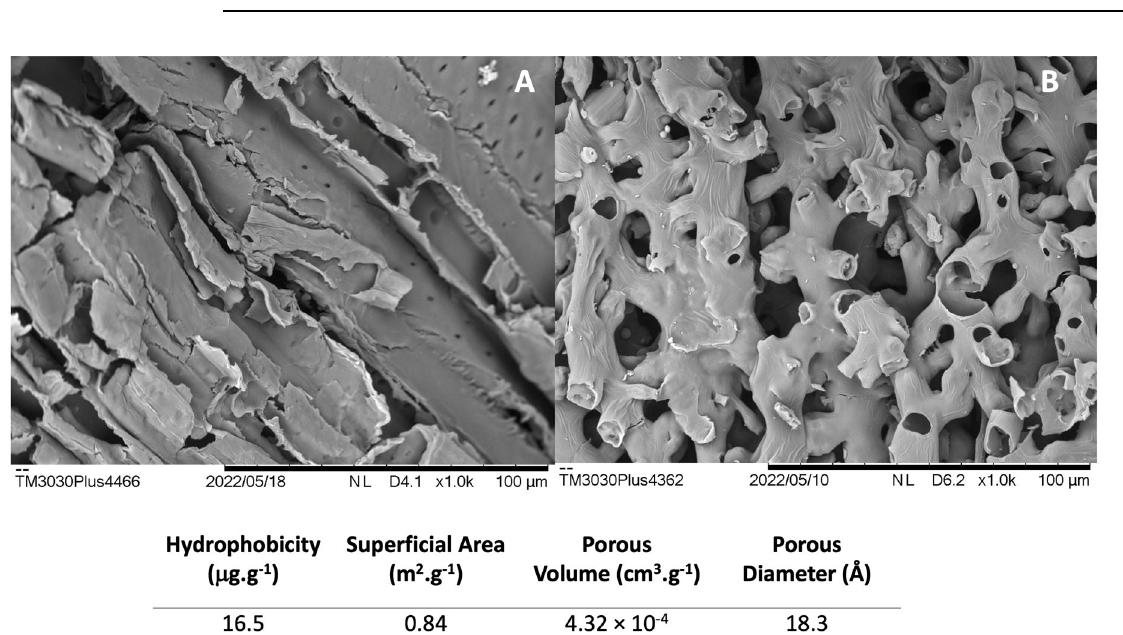
Figure 5. SEM of CC support applied on immobilization of L Asp and hydrophobicity and morphological characteristics measured by BET method and hydrophobicity of CC after degreasing process. ( A ) Corn cob in natura; ( B ) corn cob after degreasing process.